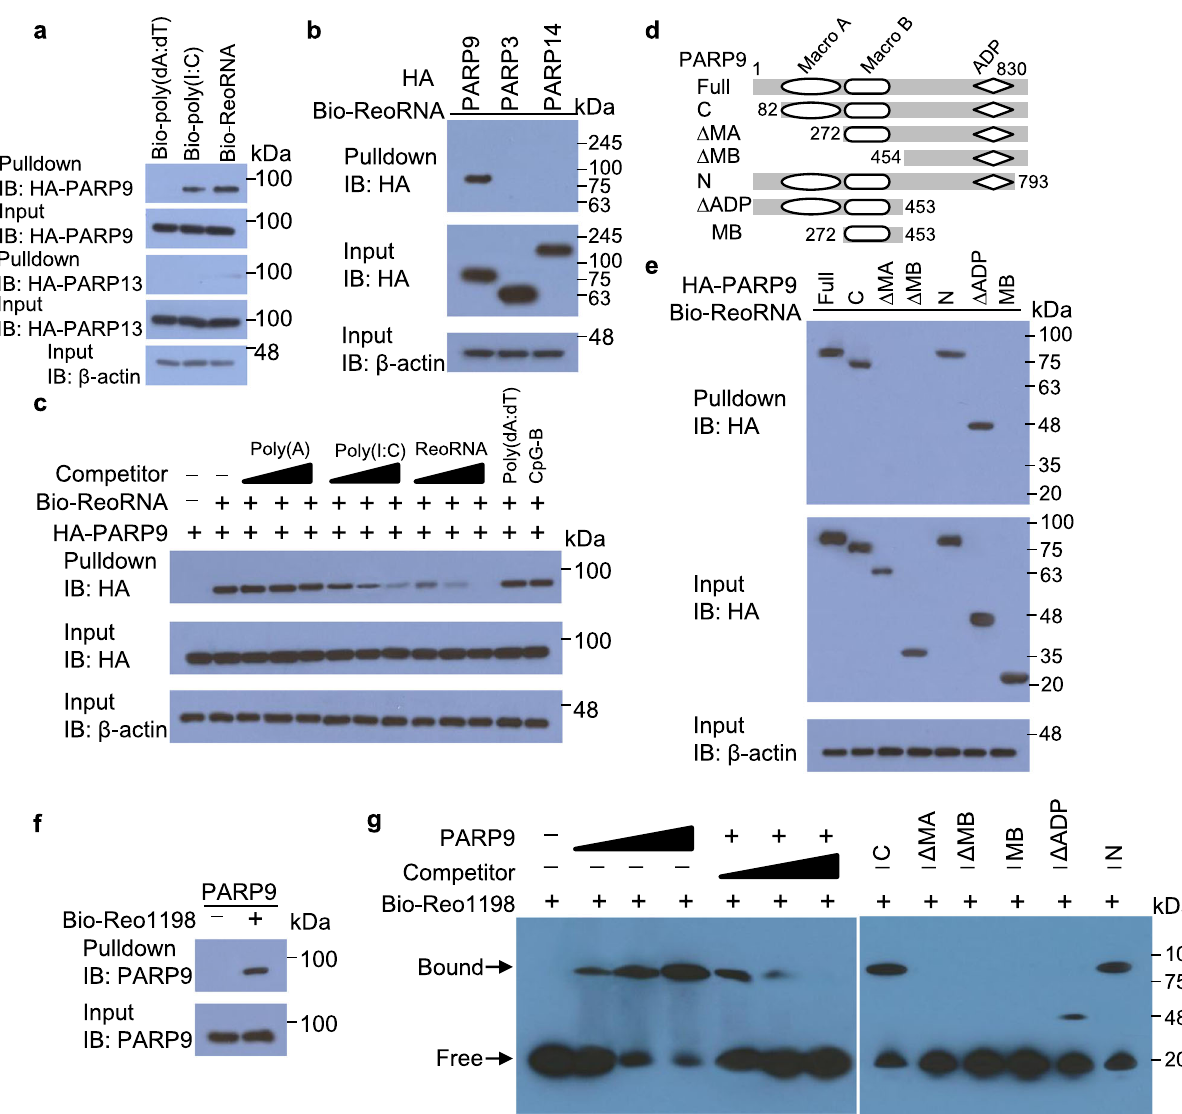
Fig. 4 PARP9 physically interacts with viral dsRNA. a Streptavidin pull-down assays of the binding of biotinylated poly(dA:dT) (Bio-poly(dA:dT)), biotinylated long poly(I:C) (Bio-poly(I:C)), or biotinylated reovirus dsRNA (Bio-ReoRNA) to puri fi ed HA-tagged PARP9 or PARP13 in HEK 293T cells. b Streptavidin pull-down assays of the binding of Bio-ReoRNA to indicated puri fi ed HA-tagged proteins in HEK 293T cells. c Streptavidin pull-down assays of the binding of Bio-ReoRNA to puri fi ed HA-tagged PARP9 without ( ‒ ) or with competitors poly (A), poly (I:C) or ReoRNA (increasing concentrations of 0.5, 5, and 50 μ g/ml), poly(dA:dT), CpG B. d Schematic diagram showing full-length PARP9 (Full) and serial truncations of PARP9 with deletion ( Δ ) of various domain (left margin); numbers at ends indicate amino acid positions (top). ADP, adenosine diphosphate. e Streptavidin pull-down assays of the binding of Bio-ReoRNA to indicated puri fi ed HA-tagged full-length and various truncatants of PARP9 in HEK 293T cells. f Streptavidin pull-down assays of the binding of biotinylated reovirus dsRNA (Bio-Reo1198) to cell-free, recombinant PARP9. g Electrophoretic mobility shift assay (EMSA) of Bio-Reo1198 with cell-free, recombinant full length PARP9 (5 μ g or increasing concentrations of 0.5, 1, and 5 μ g) or its mutants (5 μ g) without or with competitor unlabeled viral dsRNA Reo1198 at 5, 10, and 20 times molar excess. Data are representative of three independent